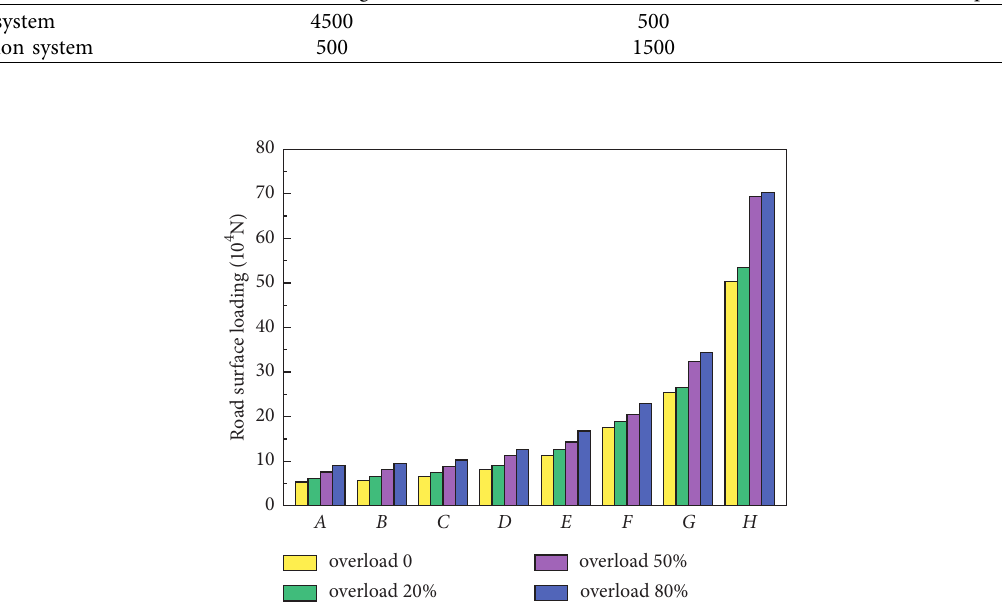
Figure 14: Impact of vehicle overload condition on road surface loading (A ∼